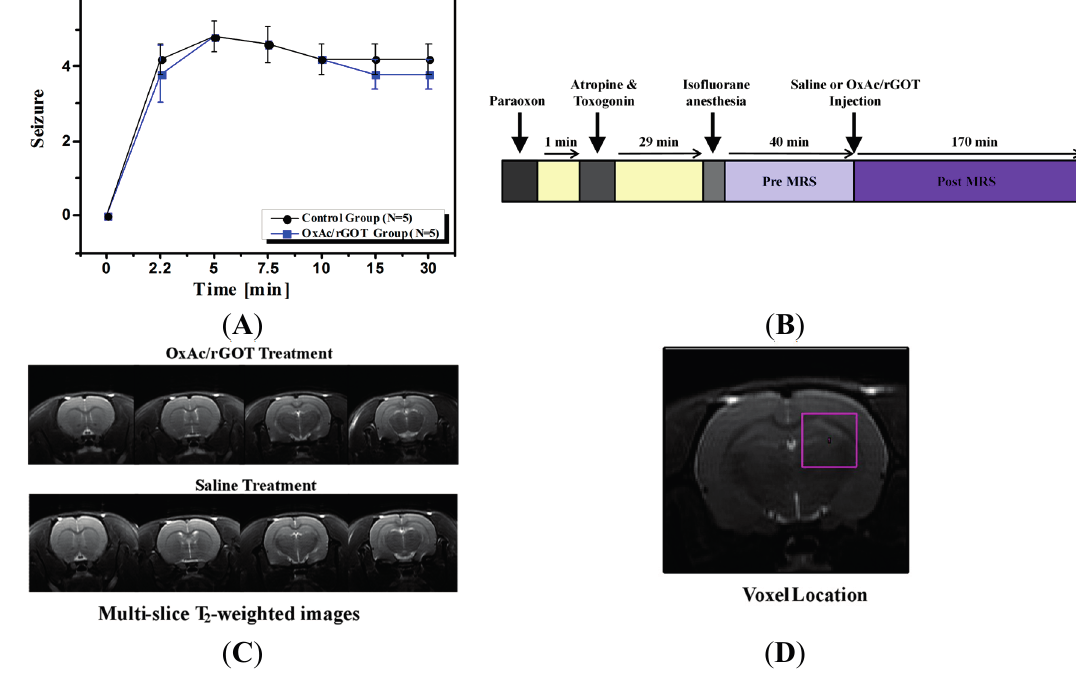
Figure 1. ( A ) Racine’s scale evaluation of seizure’s post paraoxon (PO) exposure; ( B ) magnetic resonance spectrocopy (MRS) experiment protocol scheme; ( C ) four axial T 2 (spin–spin relaxation)-MR-weighted images of representative rat brains treated with saline or oxaloacetate (OxAc)/glutamate-oxaloacetate transaminase (rGOT). The field